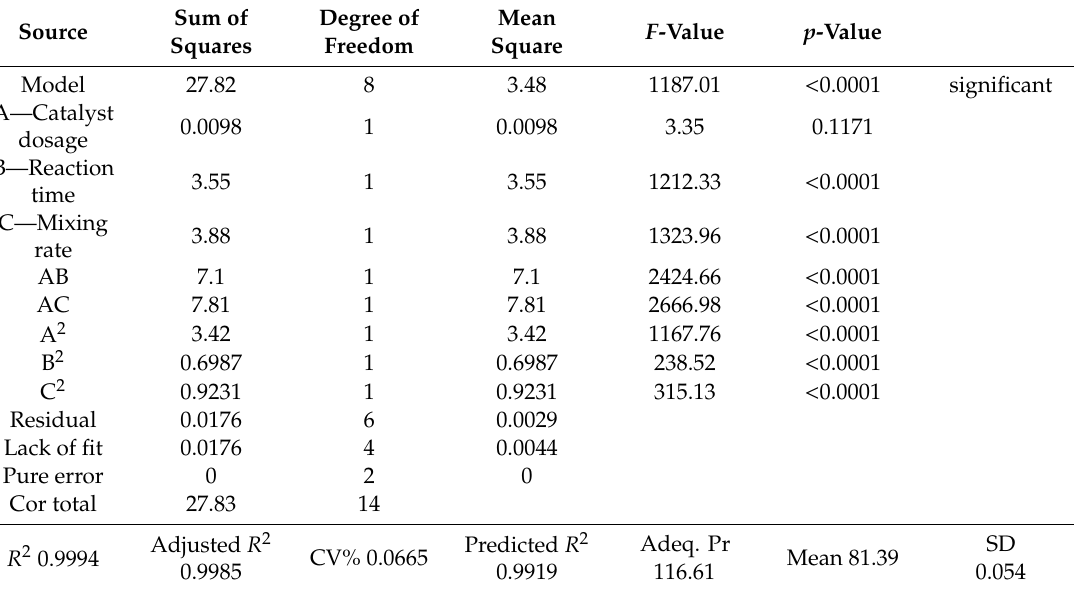
Table 8. ANOVA for SO 42 − removal by TiO 2 —reduced quadratic